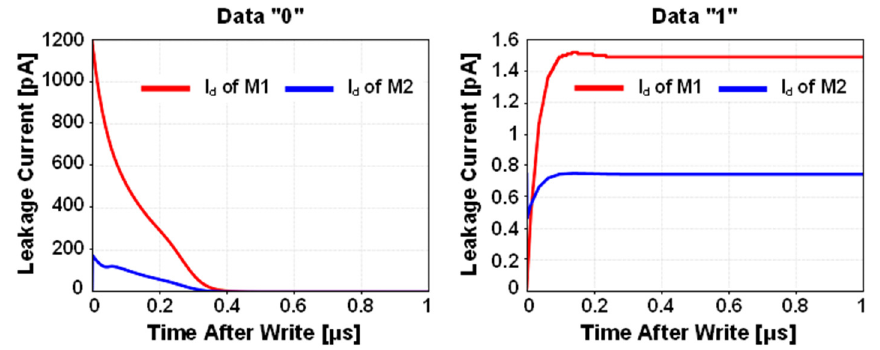
Figure 4. Simulated leakage current after write operation of 2T1C gain cell.